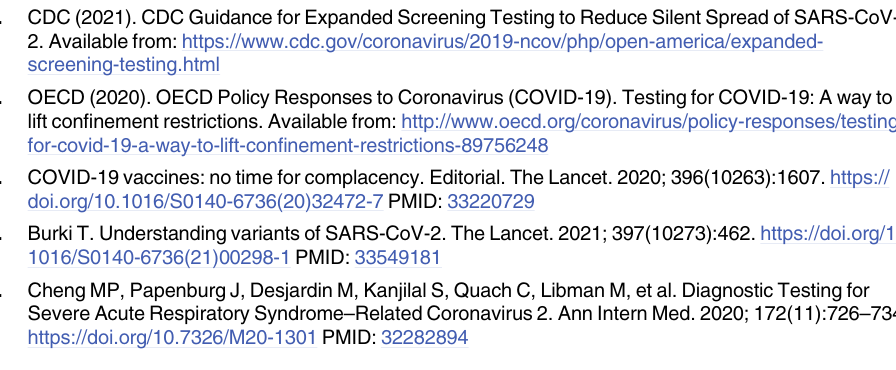
and T ), assuming that individual 0